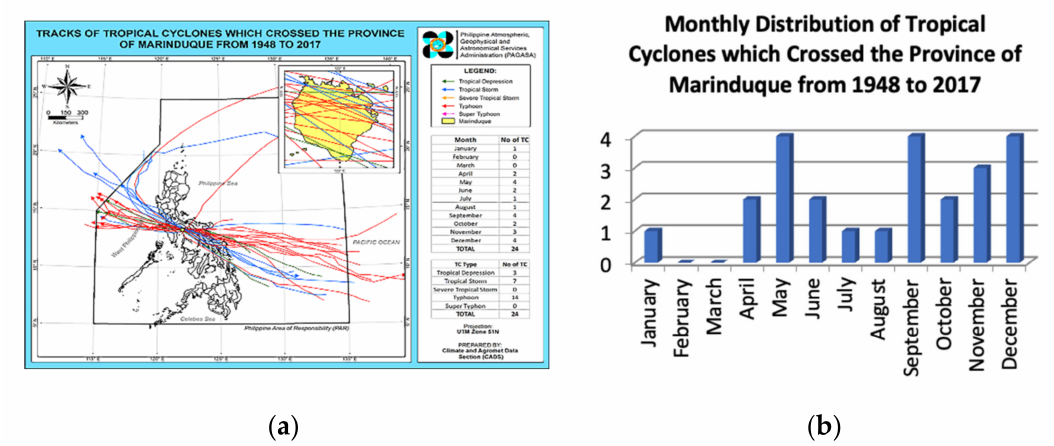
Figure 1. Typhoon Occurrences in Marinduque Province ( a ) Typhoon Tracks and ( b ) Number of typhoons that visited the island per month from 1948 to